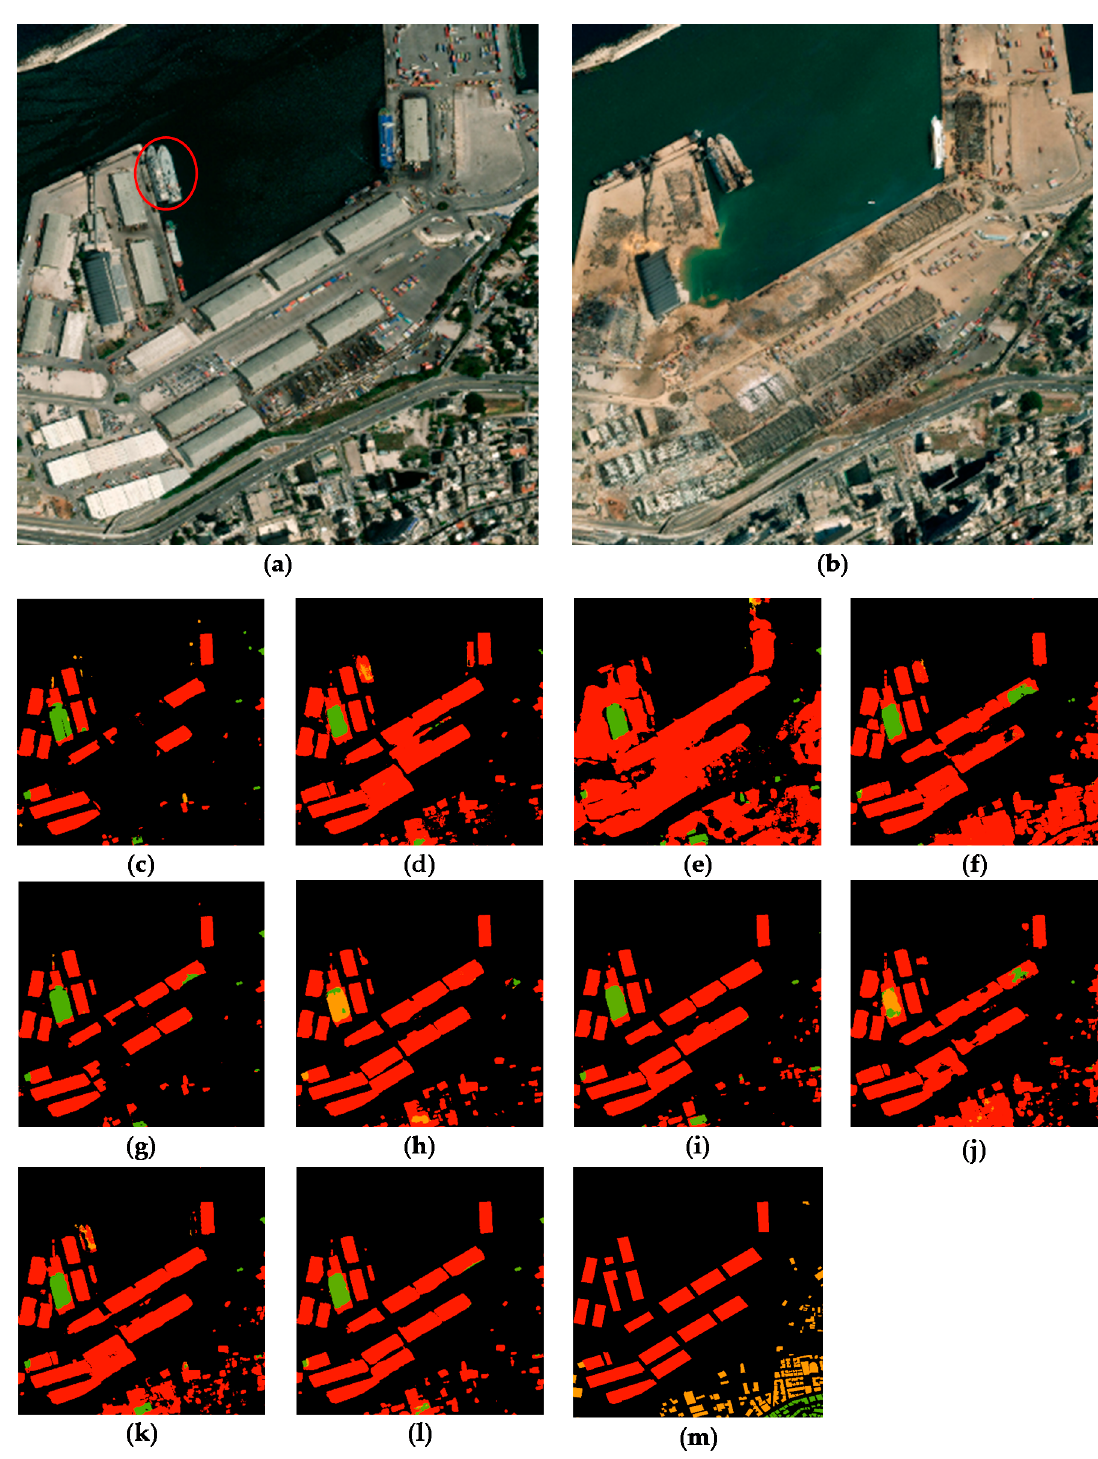
Figure 14. Beirut explosion. ( a ) Pre-disaster image, ( b ) post-disaster image, and ( m ) the GT. ( c ) The result of ResNet (w/o Figure 14. Results of Beirut explosion. ( a ) A pre-disaster image, ( b ) a post-disaster image, and ( m ) the GT. ( c ) The result of